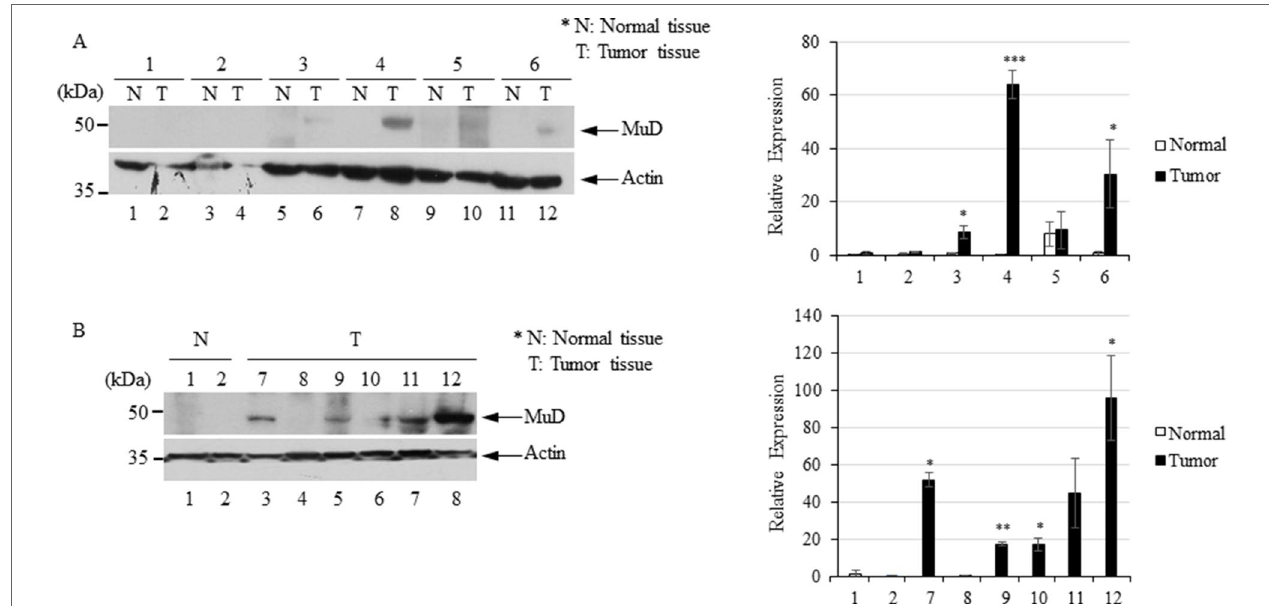
FIGURE 6 | Immunoblot analysis of MuD expression in six pairs of GBM (A) and GBM and astrocytoma biospecimens (B) . N, normal tissue; T, tumor tissue * p < 0.01, ** p < 0.005, *** p < 0.001.